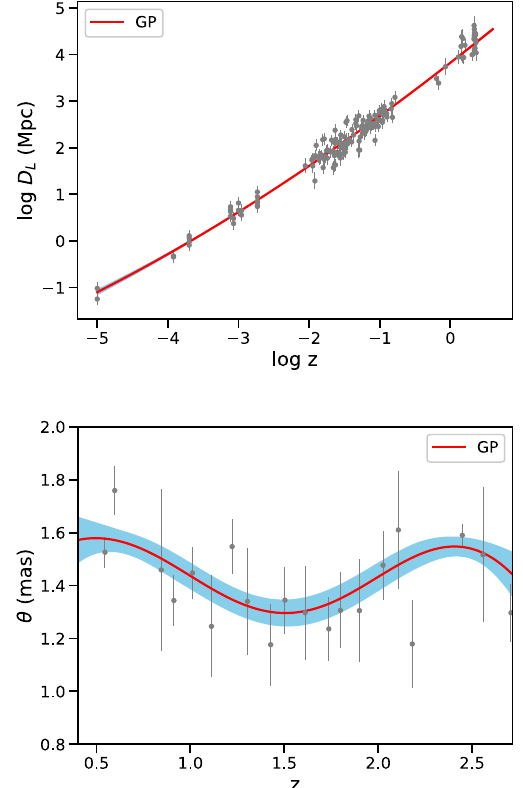
Fig. 1 Top panel: The reconstructed function log D L , HII ( z ) with cor- responding 1 σ errors by using GP (red line), and the gray dots with error bars represent measurements of HII regions; Bottom panel: The GP-reconstructed function θ( z ) from compact radio sources observa-